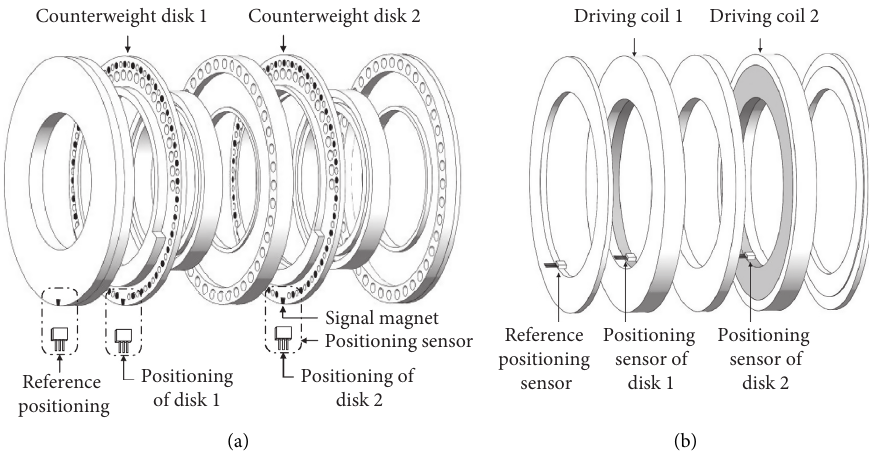
Figure 1: Schematic diagram of the balance head of the system. (a) Moving ring. (b) Static